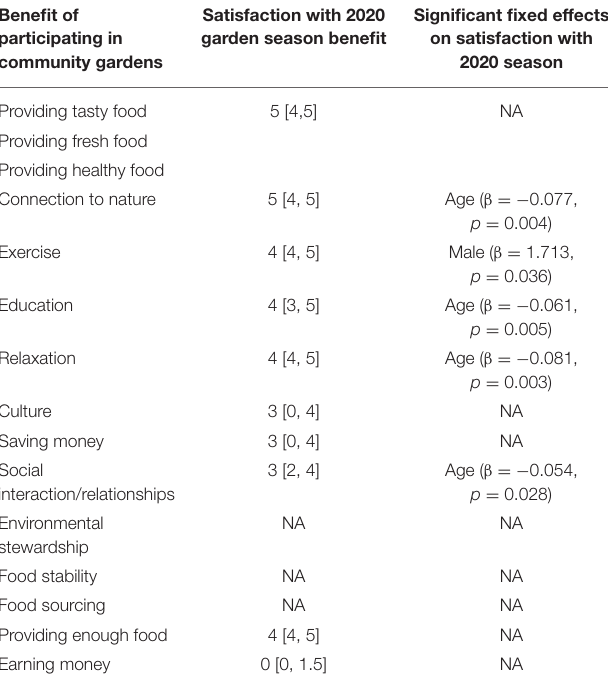
TABLE 3 | Respondents’ median Likert scores (interquartile ranges presented in brackets) for gardeners’ satisfaction with the benefits provided by participating in the 2020 community garden season, the significant fixed effects correlated with these scores (NA, 1 = very unsatisfied, 2 = somewhat unsatisfied, 3 = neither unsatisfied or satisfied, 4 = somewhat satisfied, 5 = very